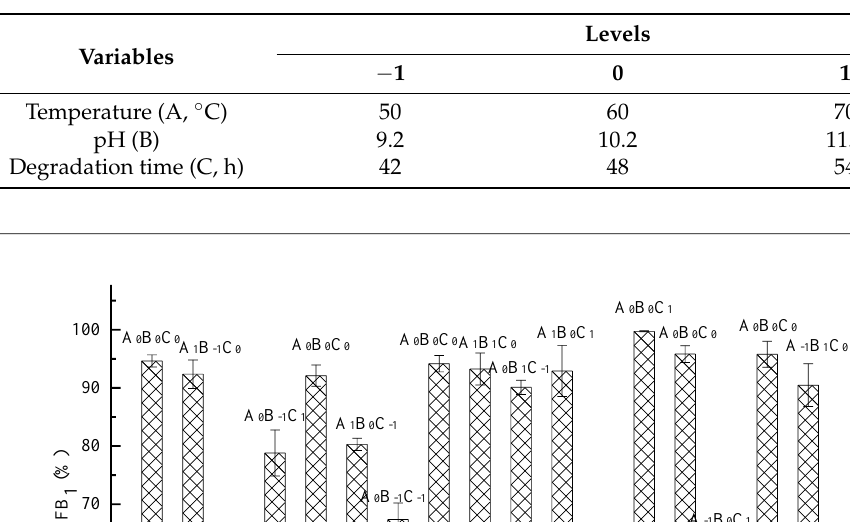
Table 1. Variables and levels employed by the Box–Behnken.